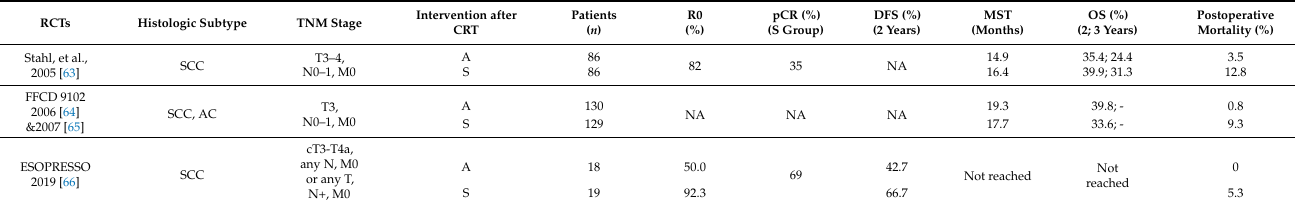
Table 4. Summary of randomized trials of surveillance vs. surgery in clinically complete responses after